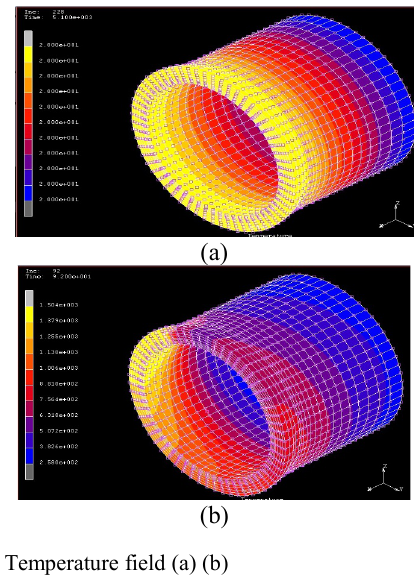
Figure 4 Thermal boundary conditions